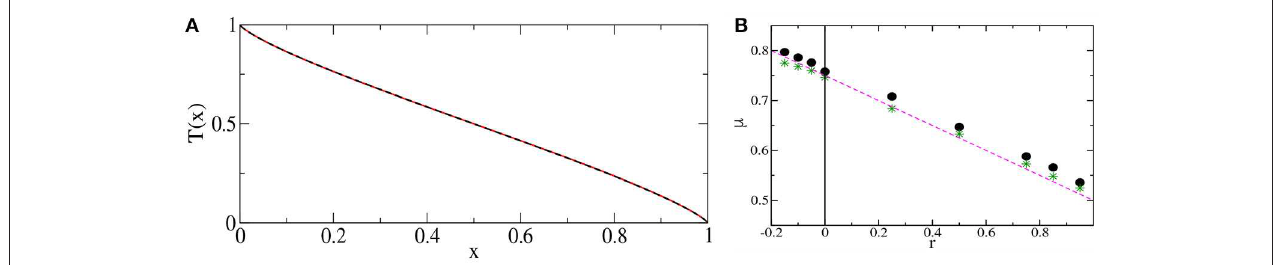
γ 1 (solid line) and solution of the master = =